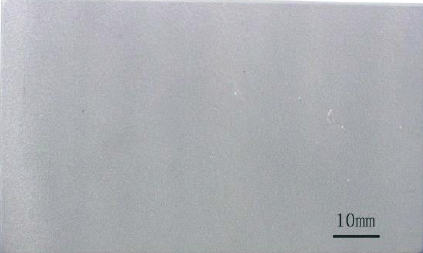
Figure 2: Macrograph of HVOF-sprayed Ni45-hBN composite